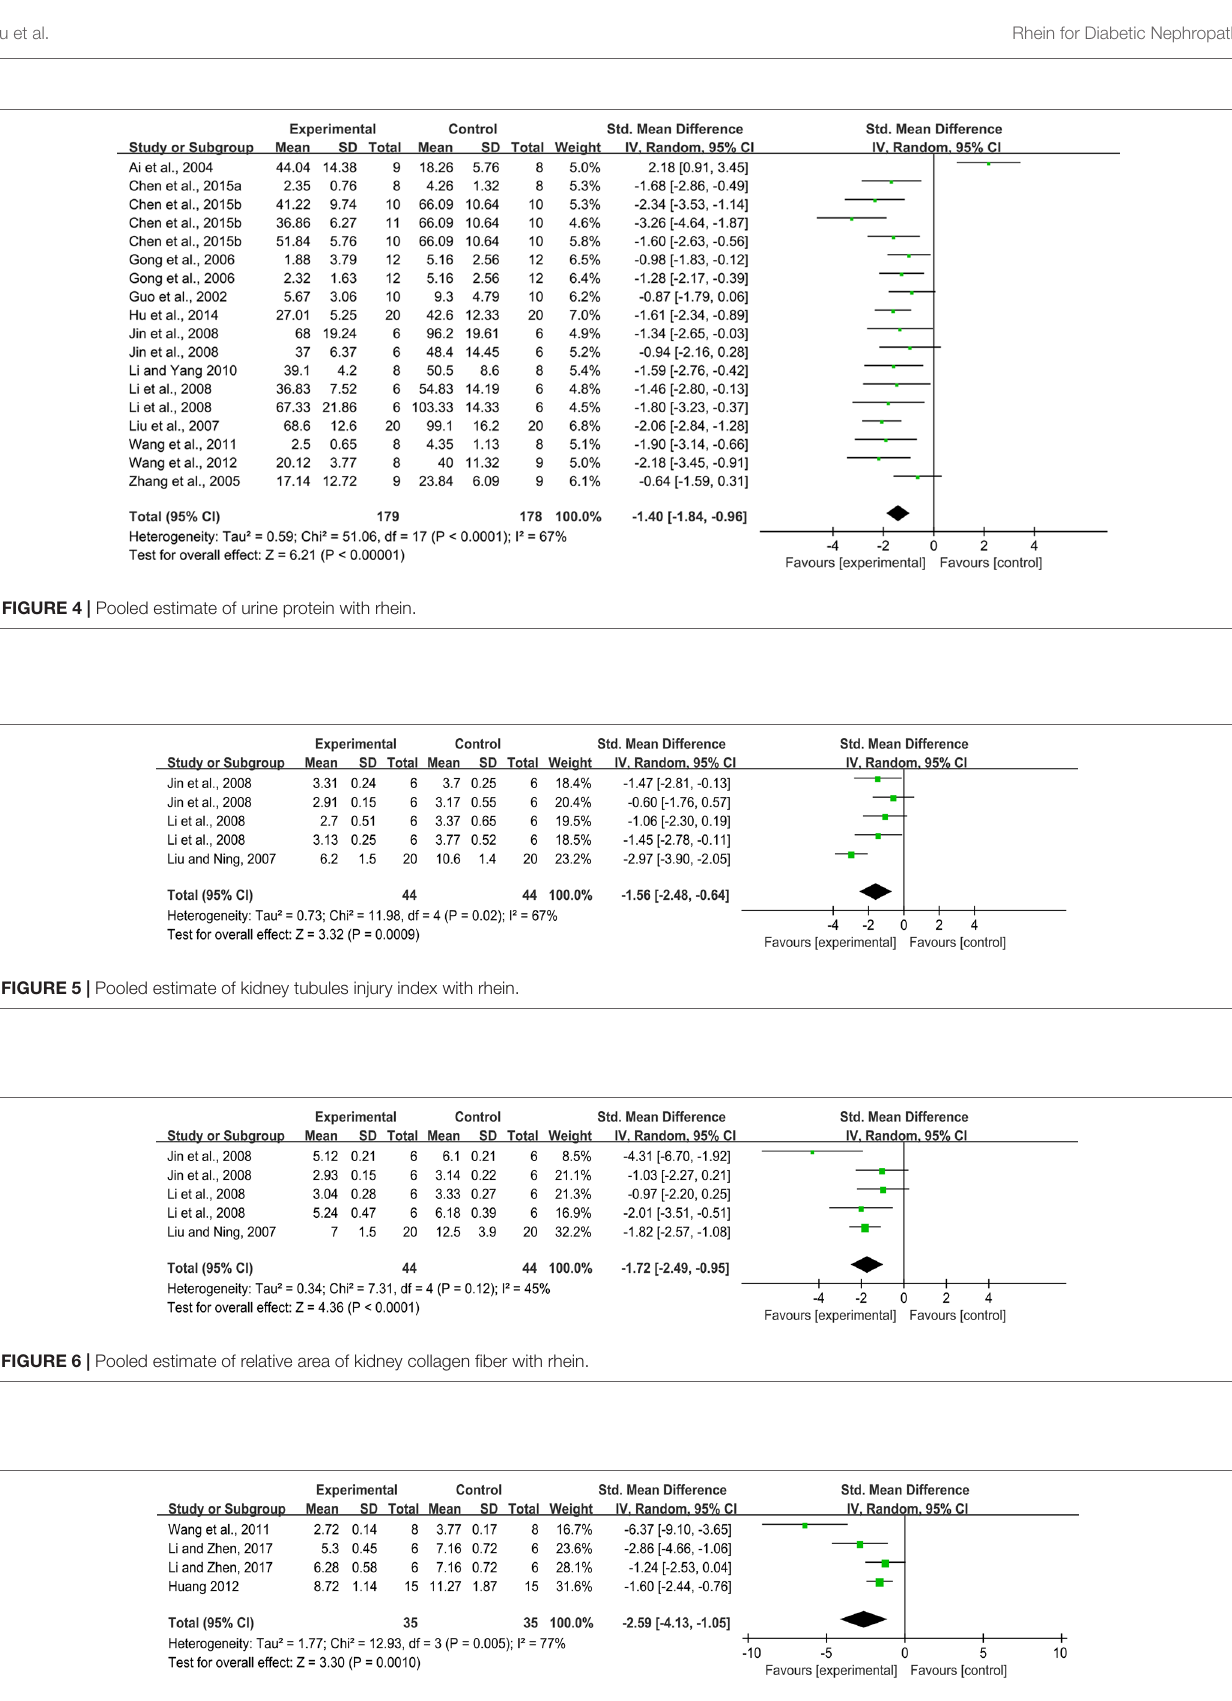
FiGURe 7 | Pooled estimate of MDA with